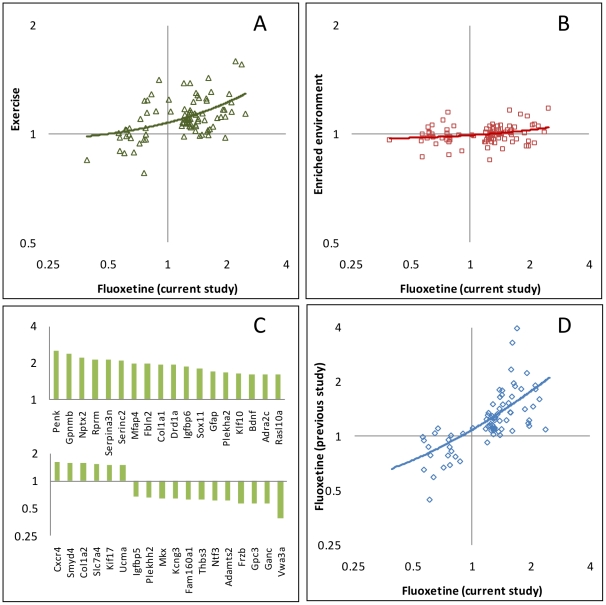
Hippocampal gene expression profiles in response to different antidepressant treatments.(A) Changes in expression following exercise compared with the changes in the fluoxetine treated group. Each point is the average expression level of the treated group divided by the average expression level in the control group for one of the 87 genes showing significant differential expression. The Y and X axes are on a log scale, base 2. The line is the best fit linear regression. (B) Changes in expression in an enriched environment as a function of the changes in the fluoxetine treated group. (C) Changes in expression for 36 genes (out of 87) with the highest fold change following chronic fluoxetine treatment compared to controls. (D) Comparison of the effect of fluoxetine on gene expression in the current study with the results obtained by Miller et al. (2008) [17].